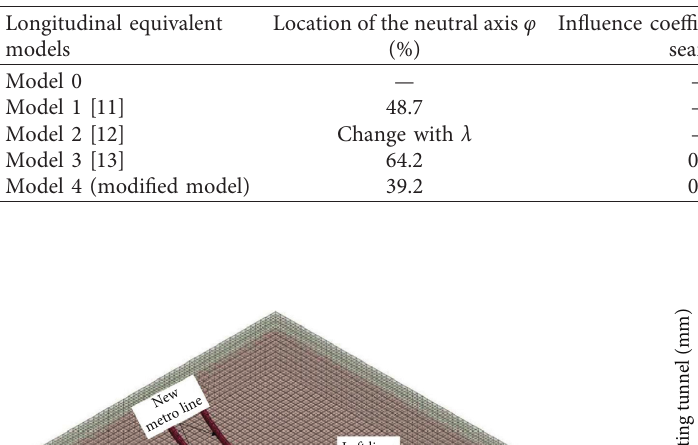
Table 4: The longitudinal equivalent stiffness models.